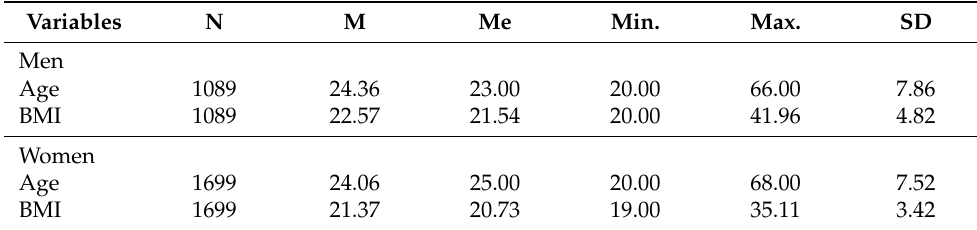
Table 1. Descriptive statistics of total results for individual